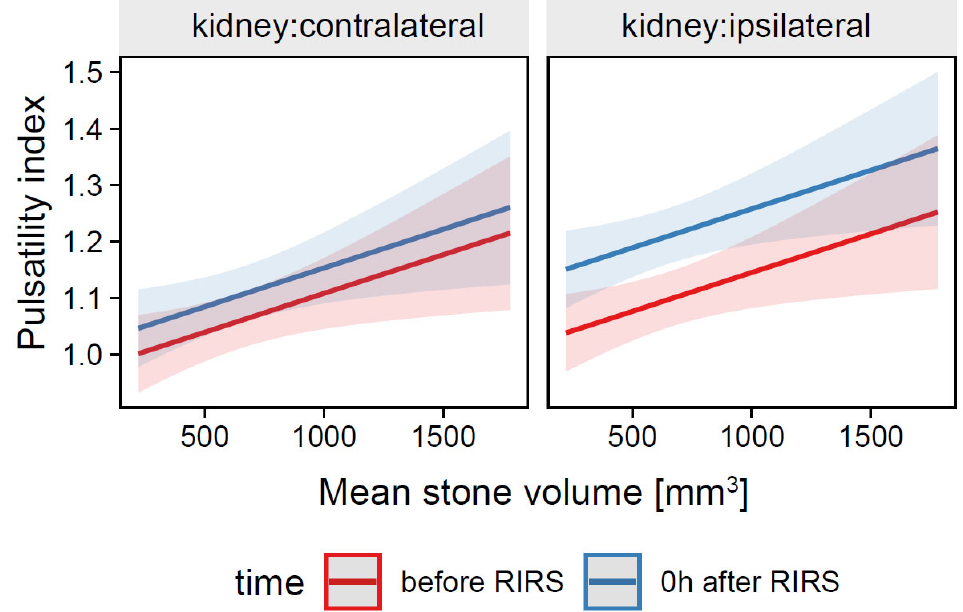
Figure 6. Predicted values (marginal effects) of pulsatility index by the Mod4 regression model for mean stone volume, time and kidney side terms.